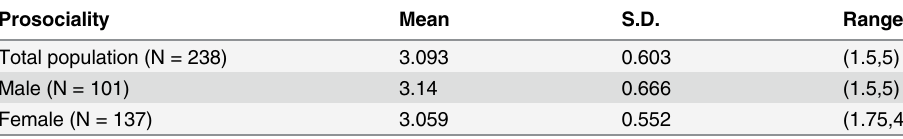
Table 3. Mean scores, standard deviation and ranges on prosociality.